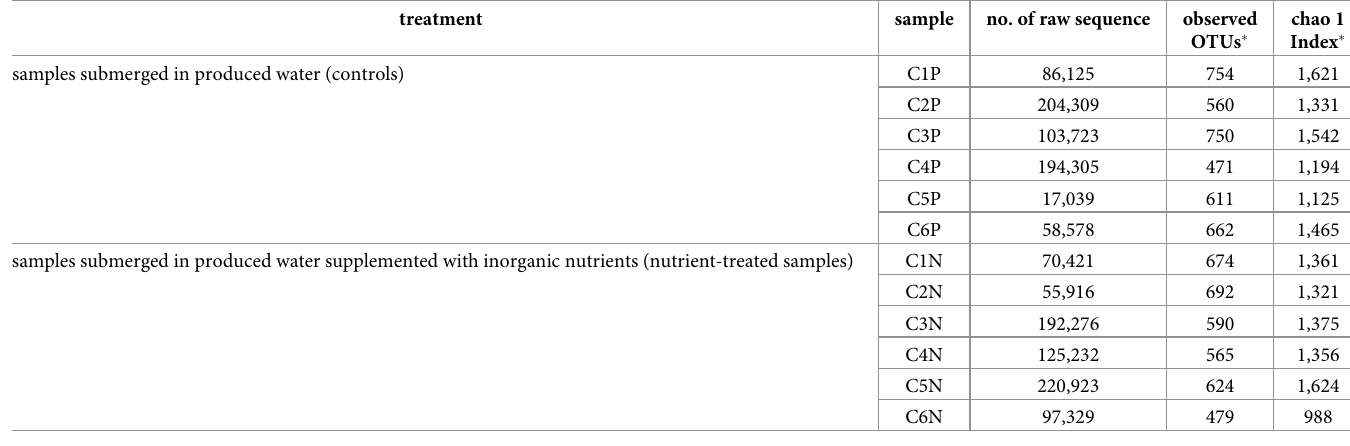
Table 5. Numbers of sequences, OTUs, and alpha diversity indices of the bacterial community in the sand core samples treated with oil well produced water and produced water supplemented with inorganic nutrients.